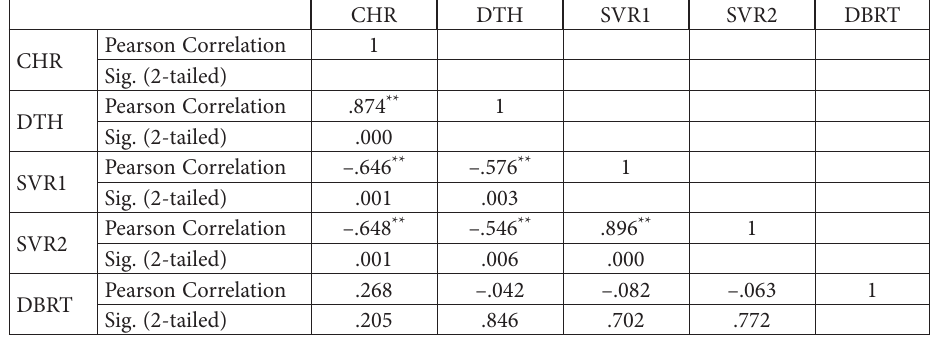
Table 10. Values of the bilateral correlations between factorial variables in Cluster B CHR DTH SVR1 SVR2 DBRT Pearson Correlation 1 CHR